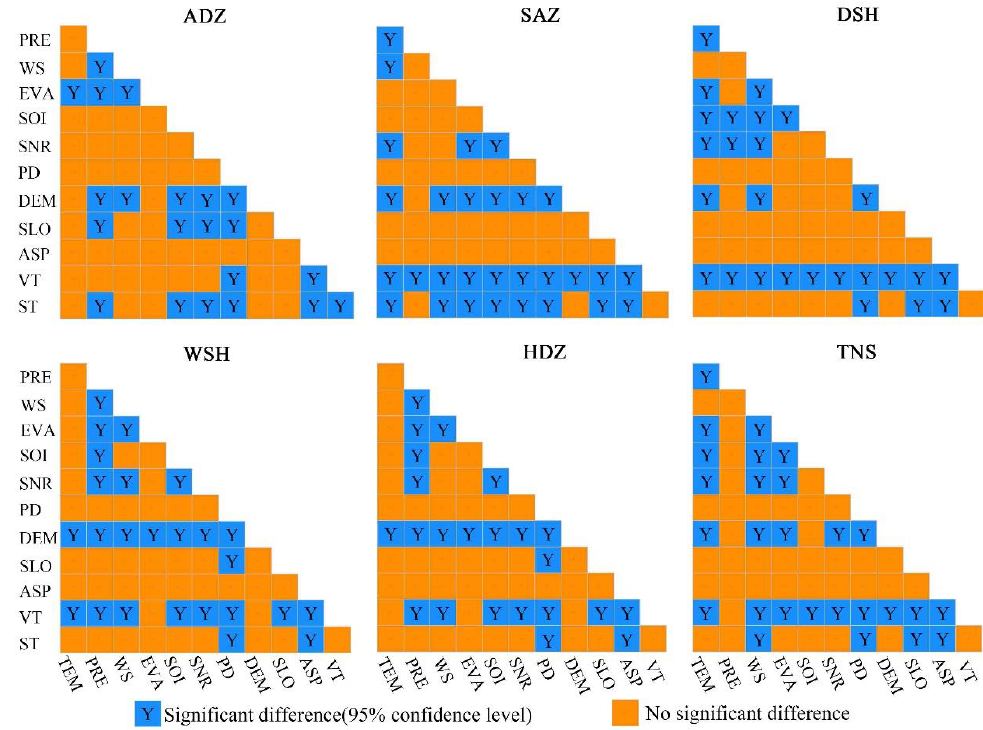
Figure 8. Significance test between drivers in the TNS and each climate zone.